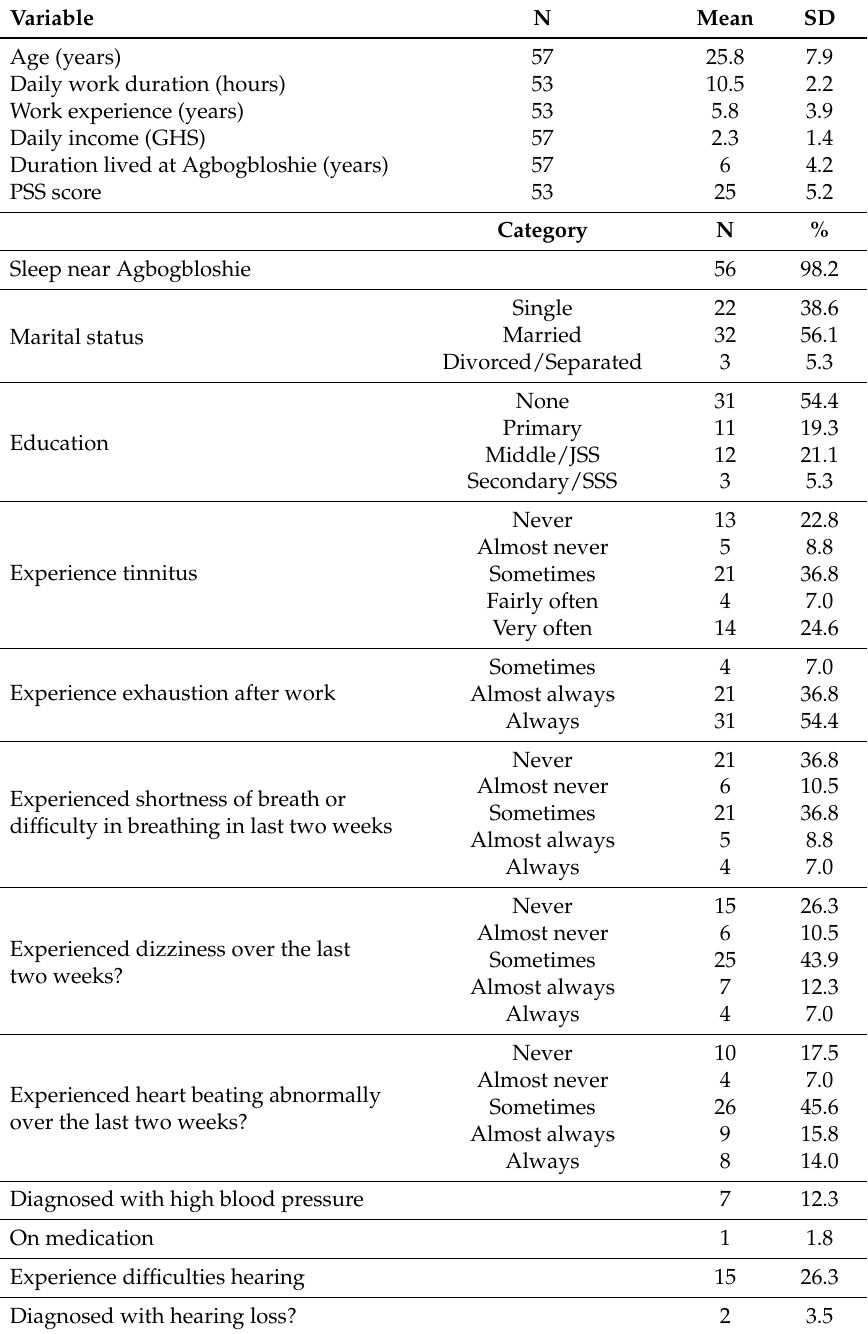
Table 1. Demographics and self reported health status ( N = 57